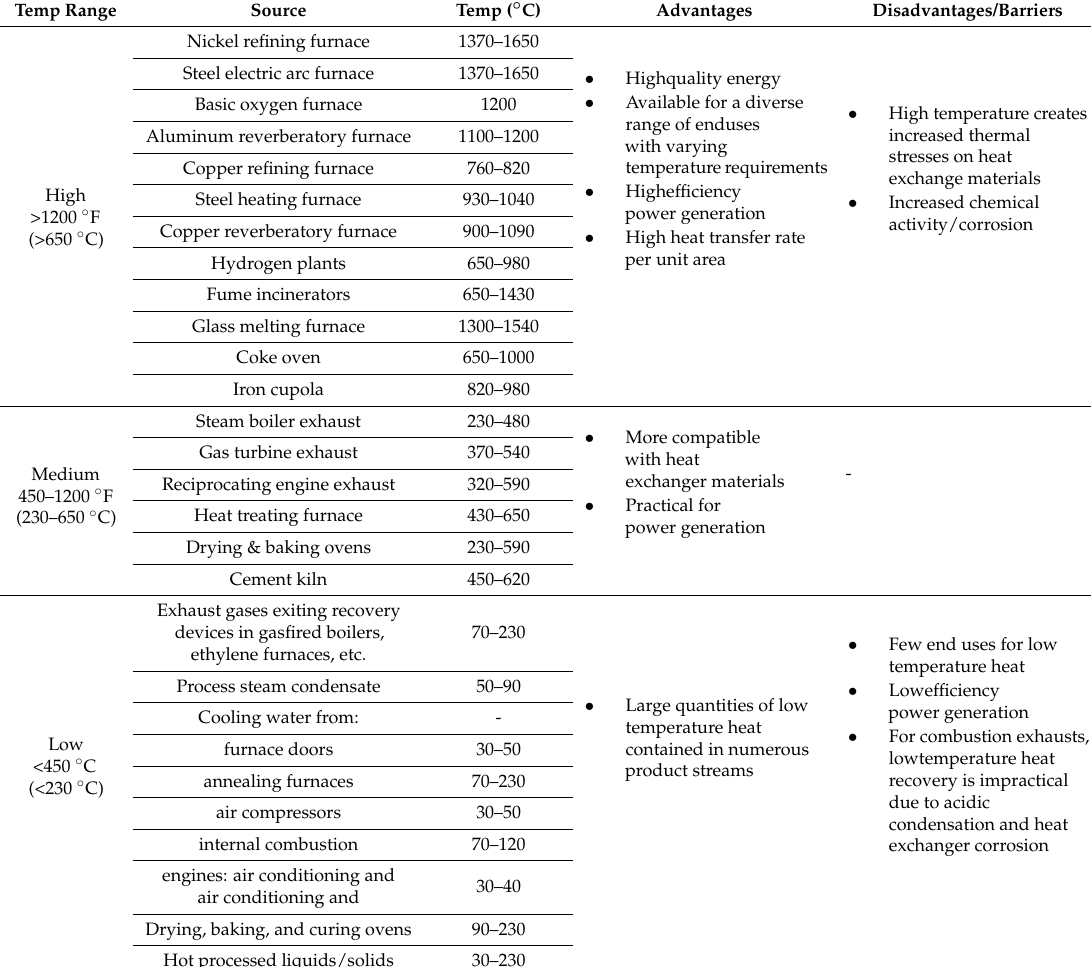
Table 1. Major waste heat sources and their temperature range